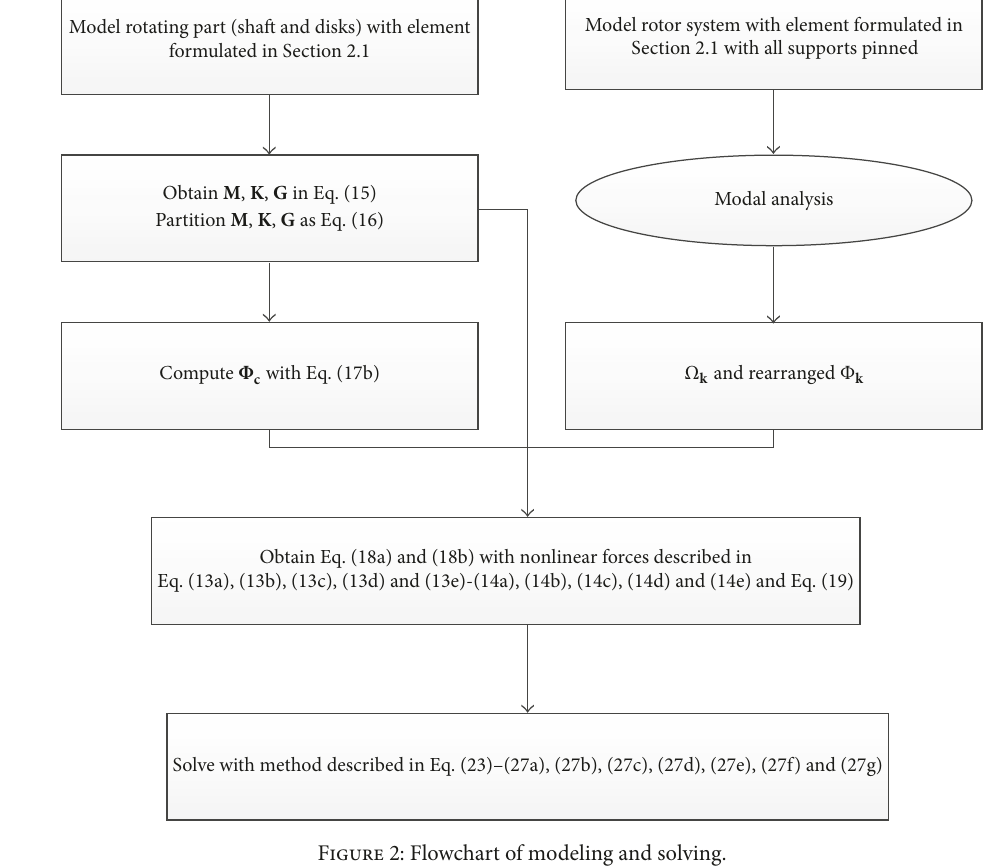
Figure 2: Flowchart of modeling and